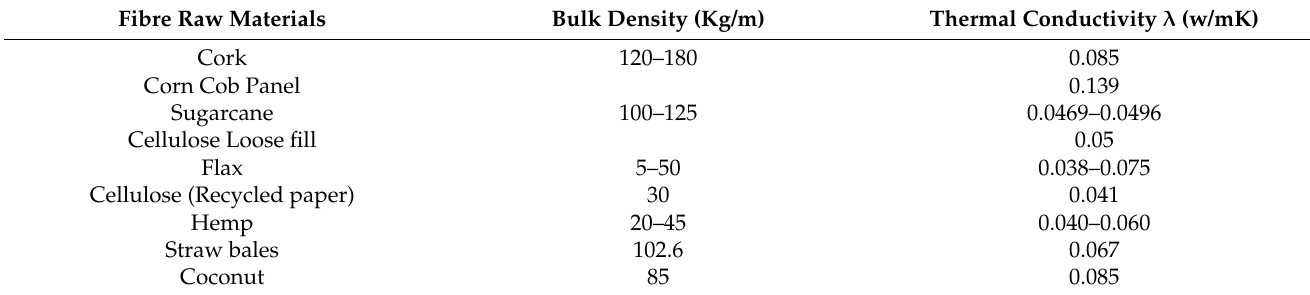
Table 1. Density and thermal conductivity values of some natural fibres used to produce LWC